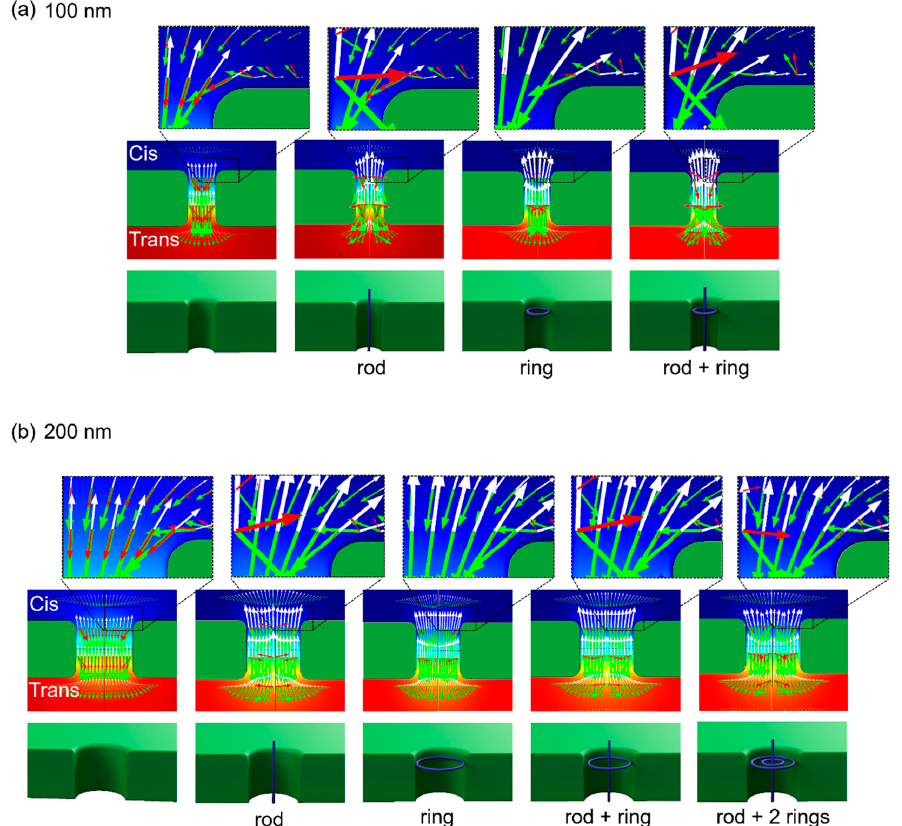
Figure 4. Numerical simulations of DNA motions with the presence of DNA at a nanopore with its diameter, 100 nm ( a ) and 200 nm ( b ). Upper: Zoomed images show the estimated DNA velocities (red arrows) at pore entrance. White arrows represent the velocities of bulk fluidic flow, while green arrows display the velocities by electrophoresis. Middle: Estimated velocities inside a pore. Lower: Schematics indicate the locations of a rod and/or a ring resembling to DNA inside a pore. In the left images simulating no DNA, the red arrows point down towards the trans side of expected translocation. In the other images hosting rod and/or ring, the | v z | of the red arrows decreased not only inside the pore but also at the pore entrances as the oppositely flow velocities (white arrows)